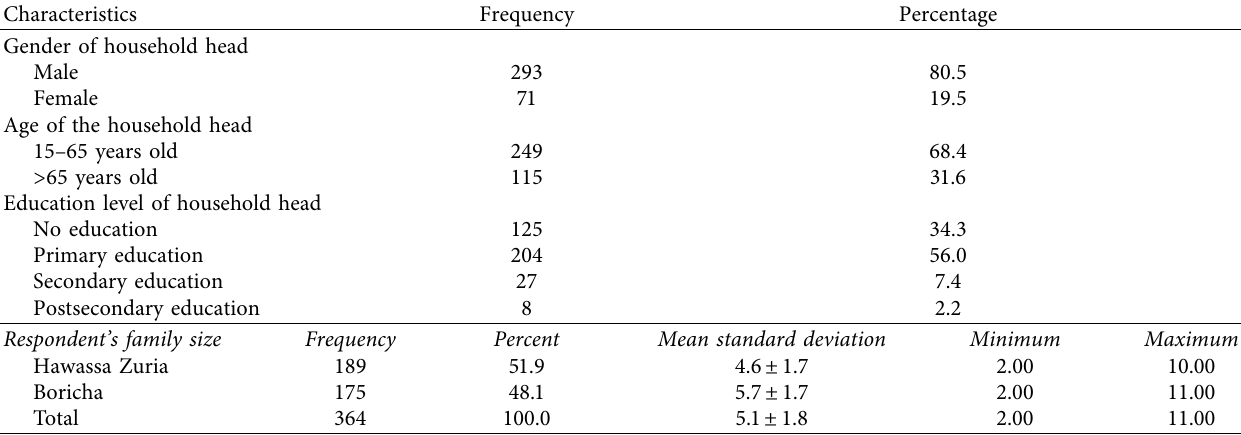
Table 1: Socioeconomic characteristics of the